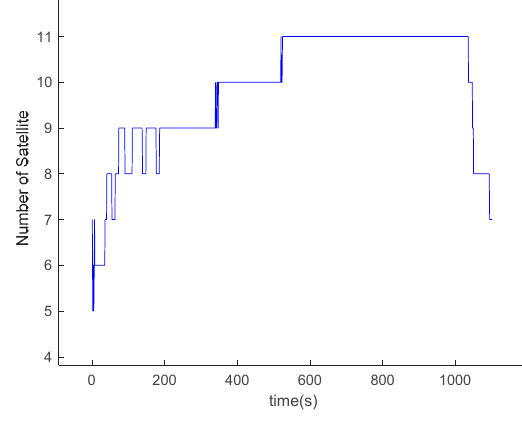
Figure 11. Number of visible satellites.